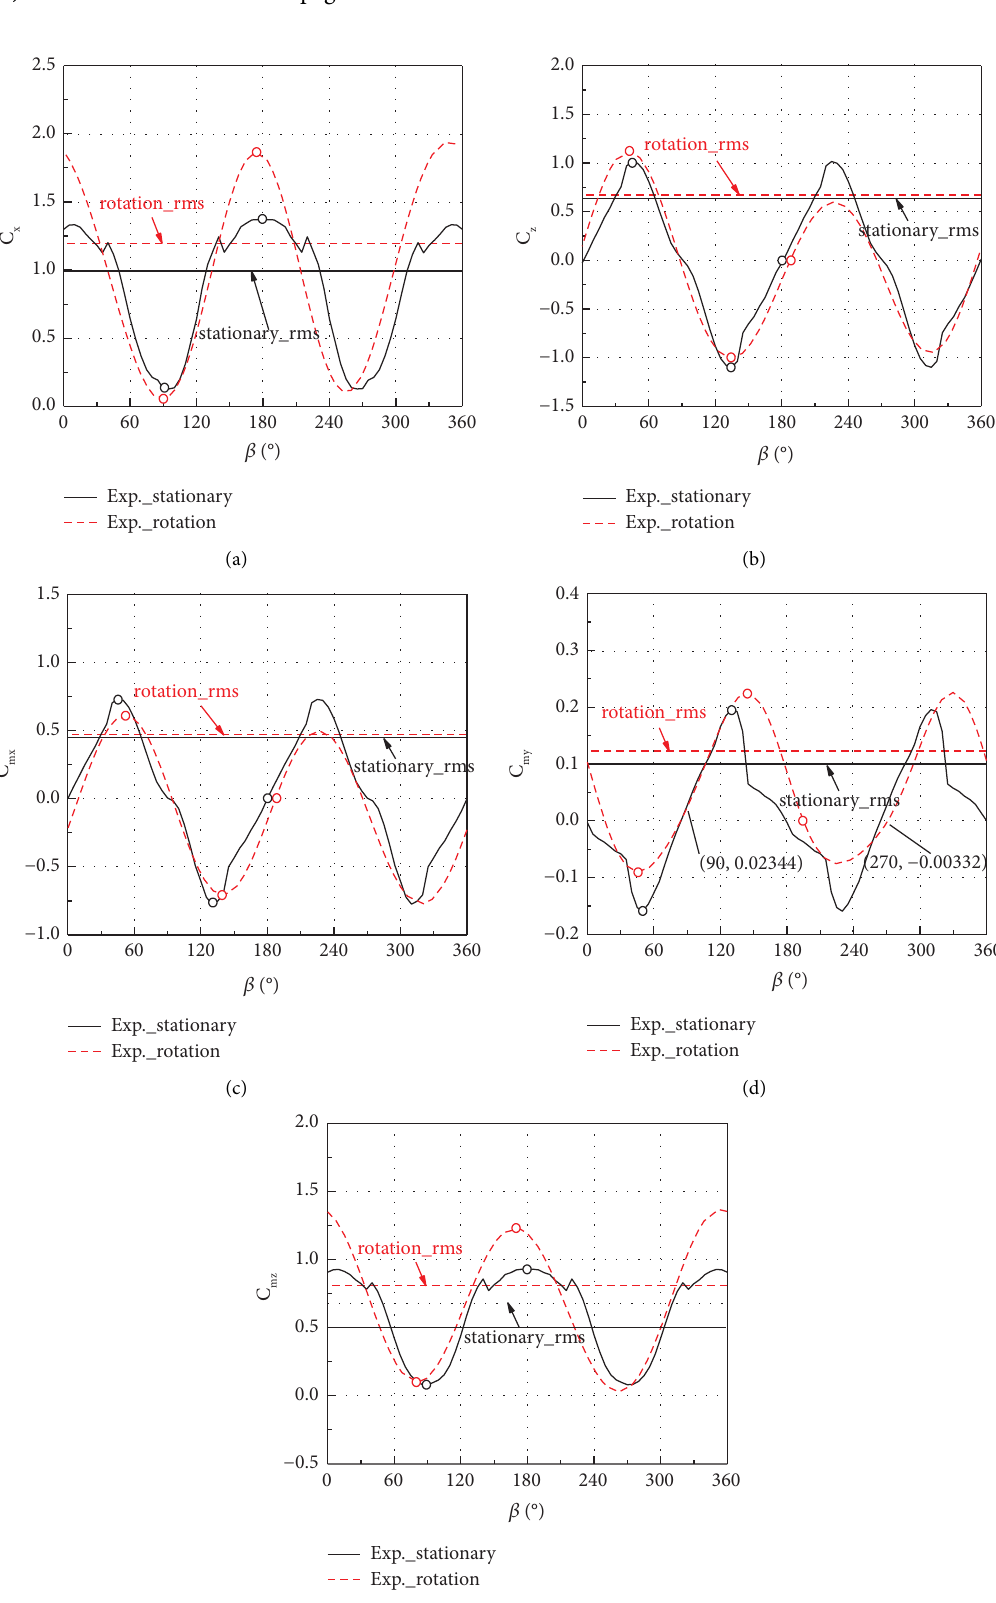
Figure 8: Wind tunnel test results and numerical simulation results of aerodynamic coefficients with respect to the azimuth angle when the antenna is stationary and azimuthal rotation (solid plate), (a) C x − β , (b) C z − β , (c) C mx − β , (d) C my − β , and (e) C mz − β